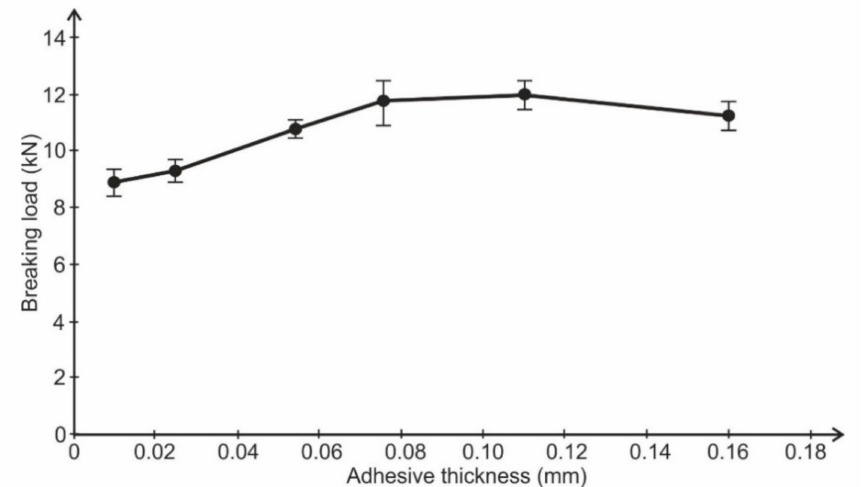
Figure 5. Dependence of lap joint strength on adhesive thickness (Epidian 57/Z1